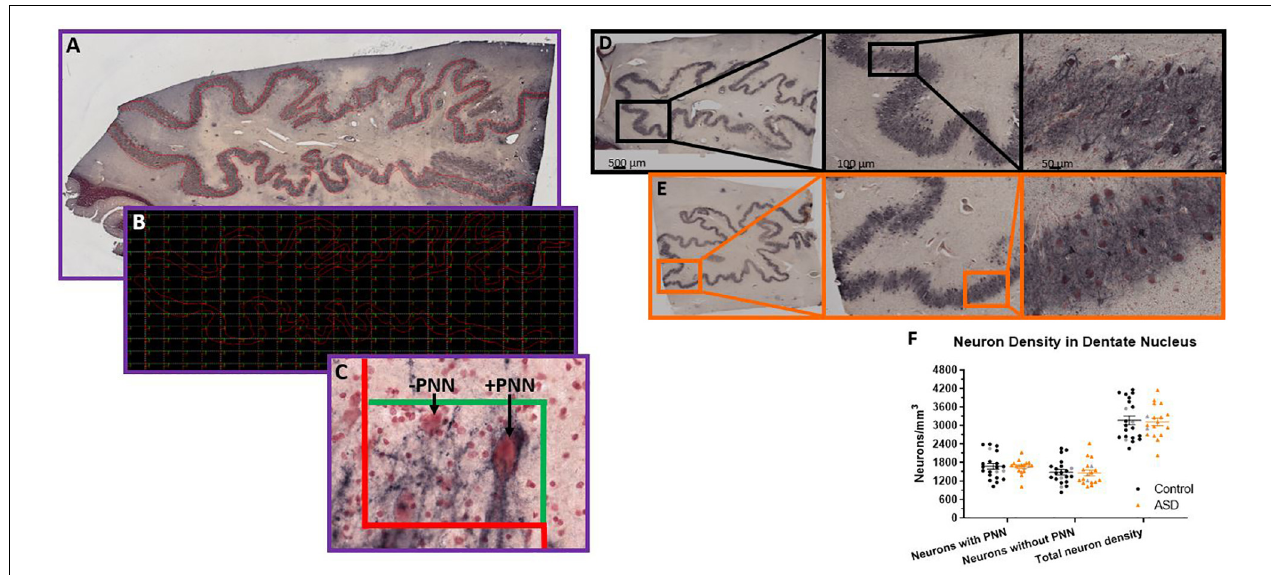
FIGURE 1 | Stereological setup for quantifying perineuronal net density in human postmortem tissue. Contours were manually drawn over the region of interest, in this case (A) , the dentate nucleus of the cerebellum. Contours were placed at a consistent distance from the edge of the dentate to mainly capture the high perineuronal net density locations in the center of the ribbon-like region. Therefore, the boxes actually counted within the grid placed over the contour in the software (B) would only be areas with a high density of neurons. Unstained regions are not represented. In this manner, unbiased counts can be achieved following established stereological methods, where neurons falling on the red line of the counting box (C) are not counted and any neurons falling within the box or on the green line are counted. Arrows point to examples of a dentate neuron surrounded by a perineuronal net and an example of a neuron stained with neutral red, but not surrounded by a perineuronal net. The neuron in the lower left would not be counted because it falls on the dissector red line, but otherwise would be PNN positive since it has an outline of black around the soma (albeit lighter than the other cell) and dark proximal axon area. (D) Immunohistochemistry of HPLN1 to visualize neurons surrounded by a perineuronal net while all neurons are stained with neutral red in a control (D) and ASD (E) case of the dentate nucleus within the cerebellum. (F) The density of neurons surrounded by a perineuronal net (PNN), without a PNN and therefore the total density of all neurons within the dentate were not significantly different between control and ASD cases, measured by a Student’s t -test. Females in each group are identified as gray colored symbols.